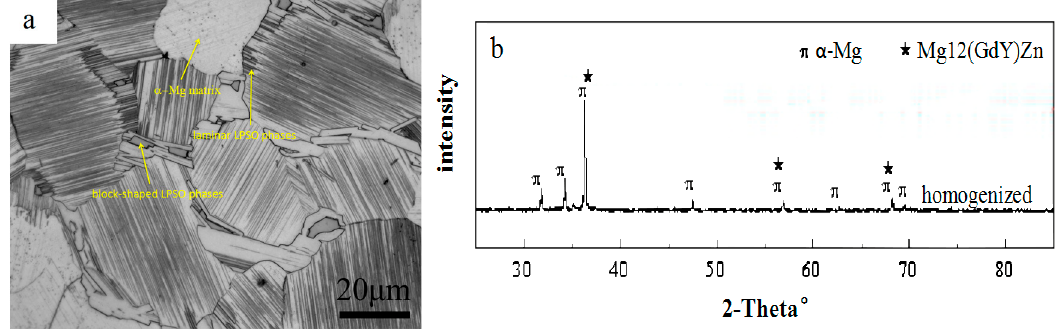
Figure 2. ( a ) The optical microscopy (OM, Zeiss, Jena, Germany) image after homogenization, and ( b ) the XRD spectrum after